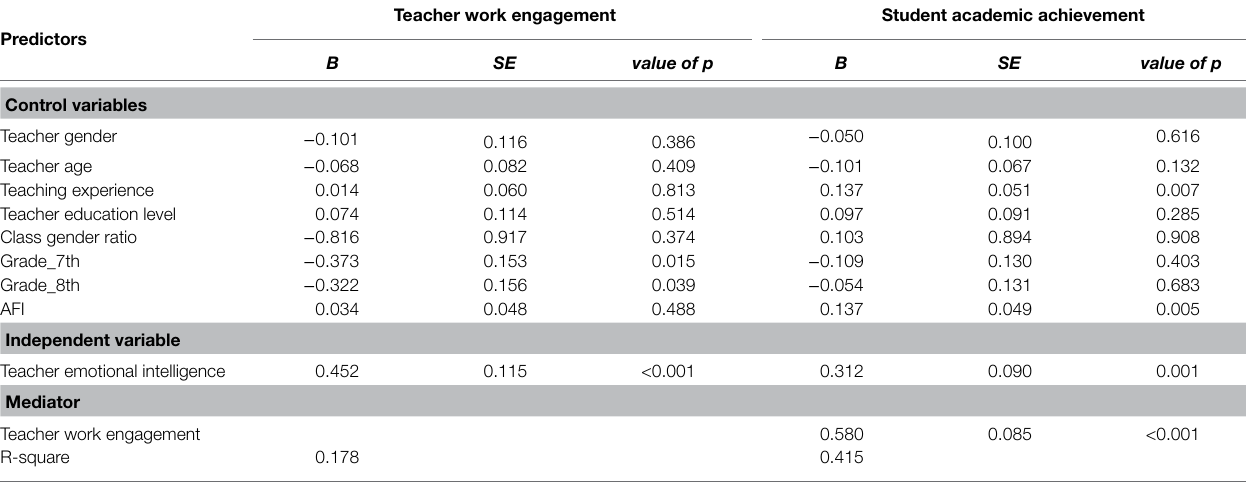
TABLE 3 | Mediating effect of teacher work engagement.